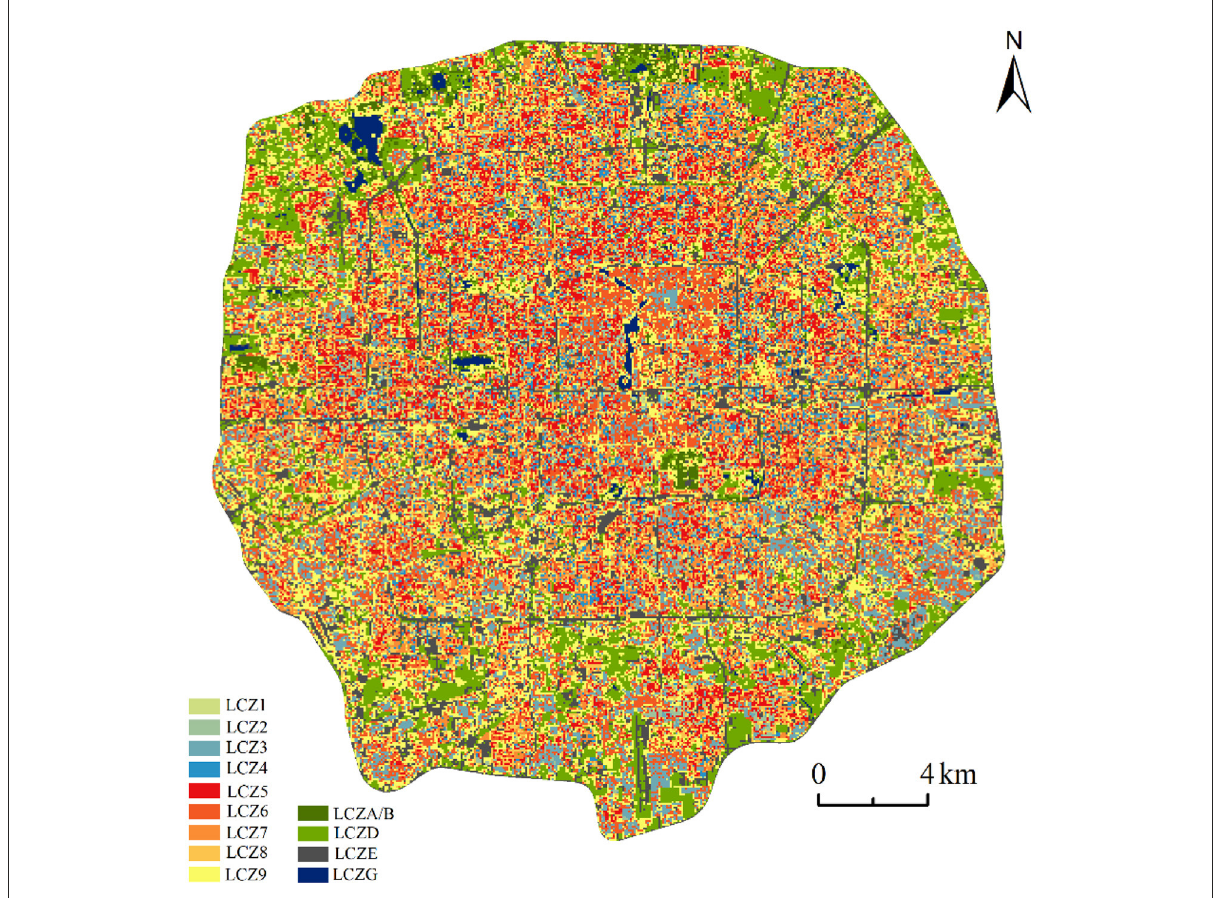
FIGURE2 Urban local climate zone (LCZ) map of the study area.